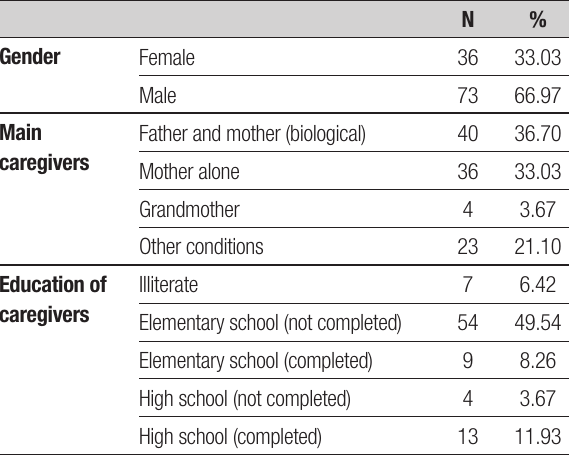
Table 1. Demographic variables of the 109 children assessed.